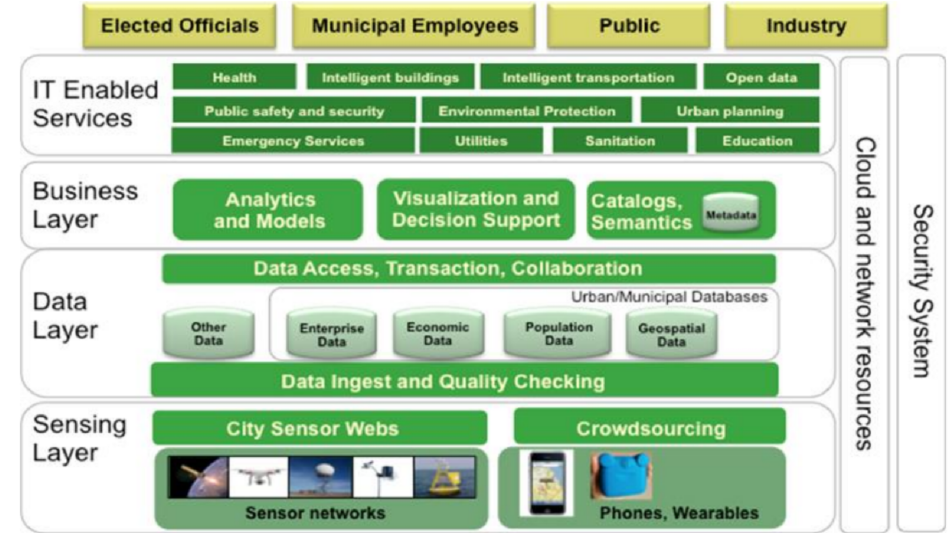
Figure 2. ESPRESSO urban platform architecture reference